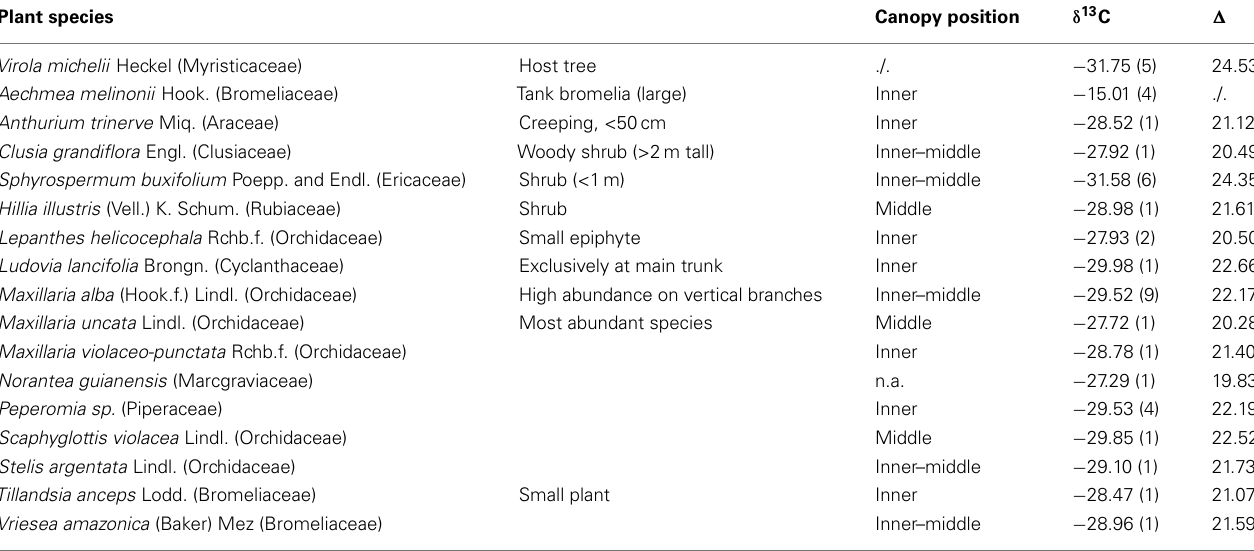
Table 1 | Epiphyte species stable isotope values, that were recorded over the 3months measuring period within the canopy of the Virola tree. Plant